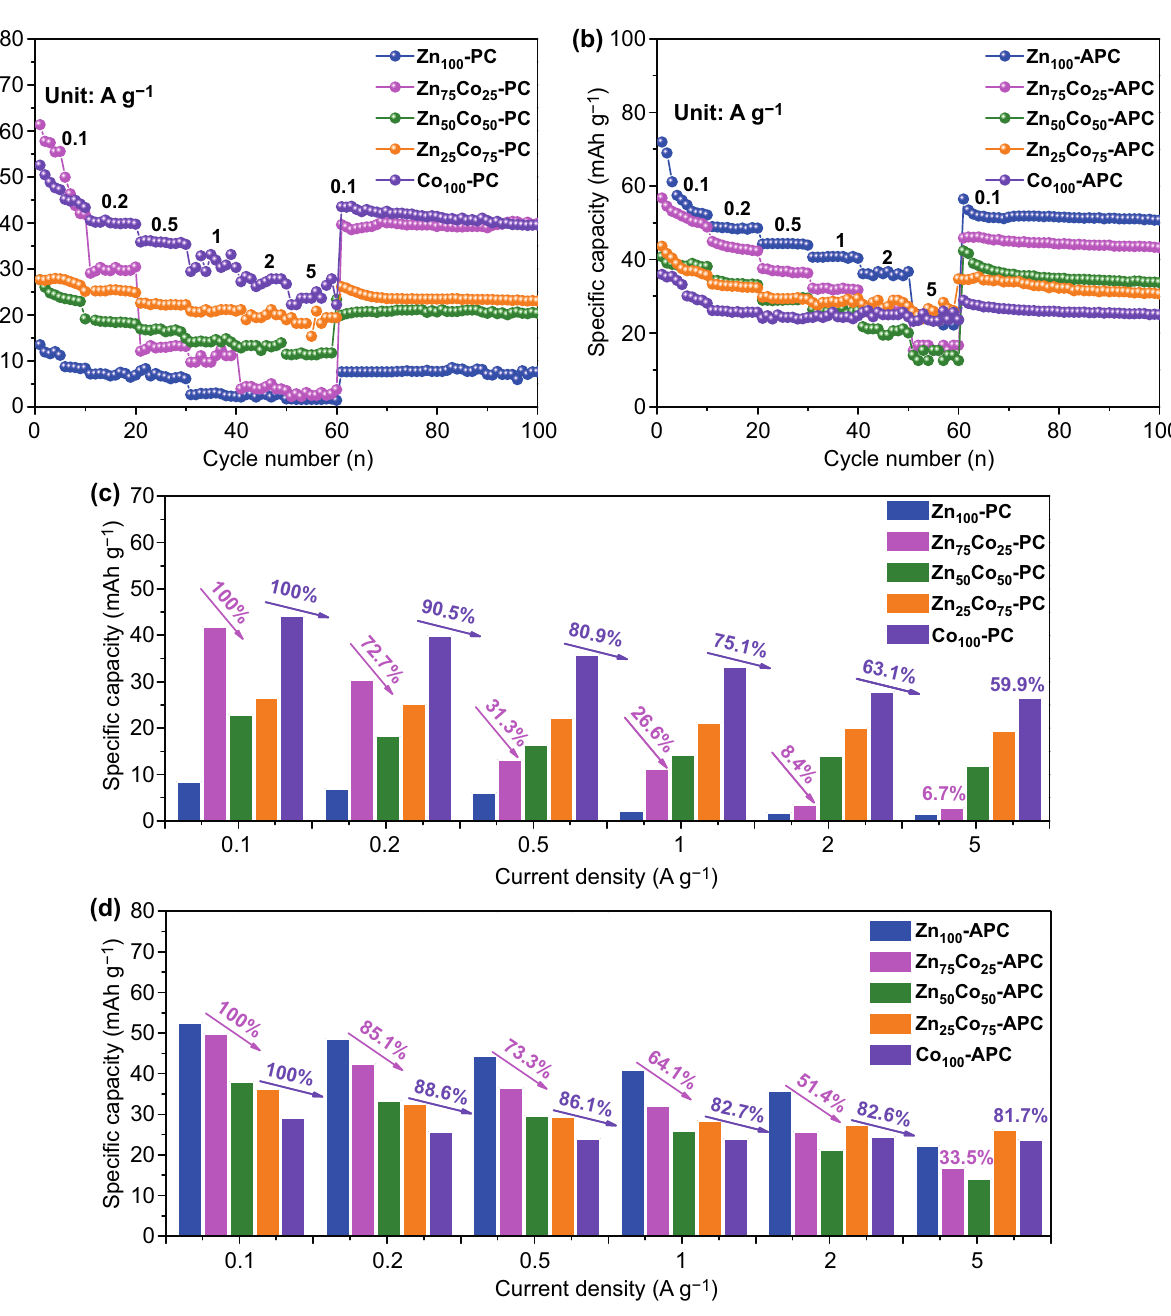
Fig. 4 Rate capabilities and comparisons of specific capacities at different current densities of a , c Zn x Co 100− x –PCs and b , d Zn x Co 100− x